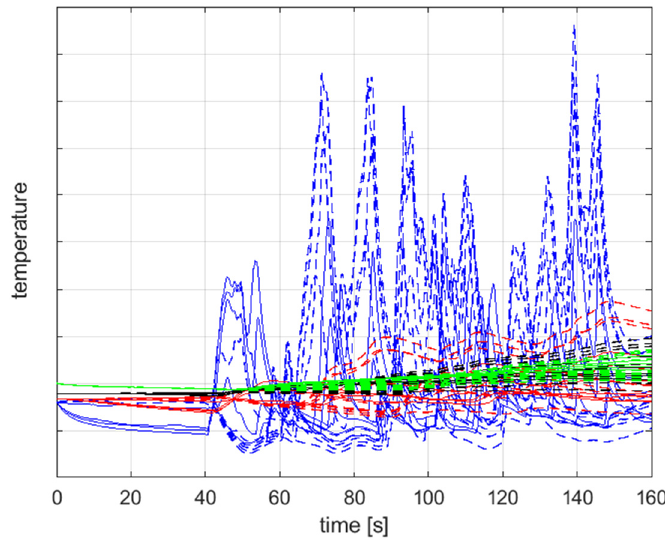
Figure 6. Tire temperatures of all the tire layers obtained by means of the thermoRIDE model: tread surface (in blue), tread core (in red), tread base (in black) and innerliner (in green).